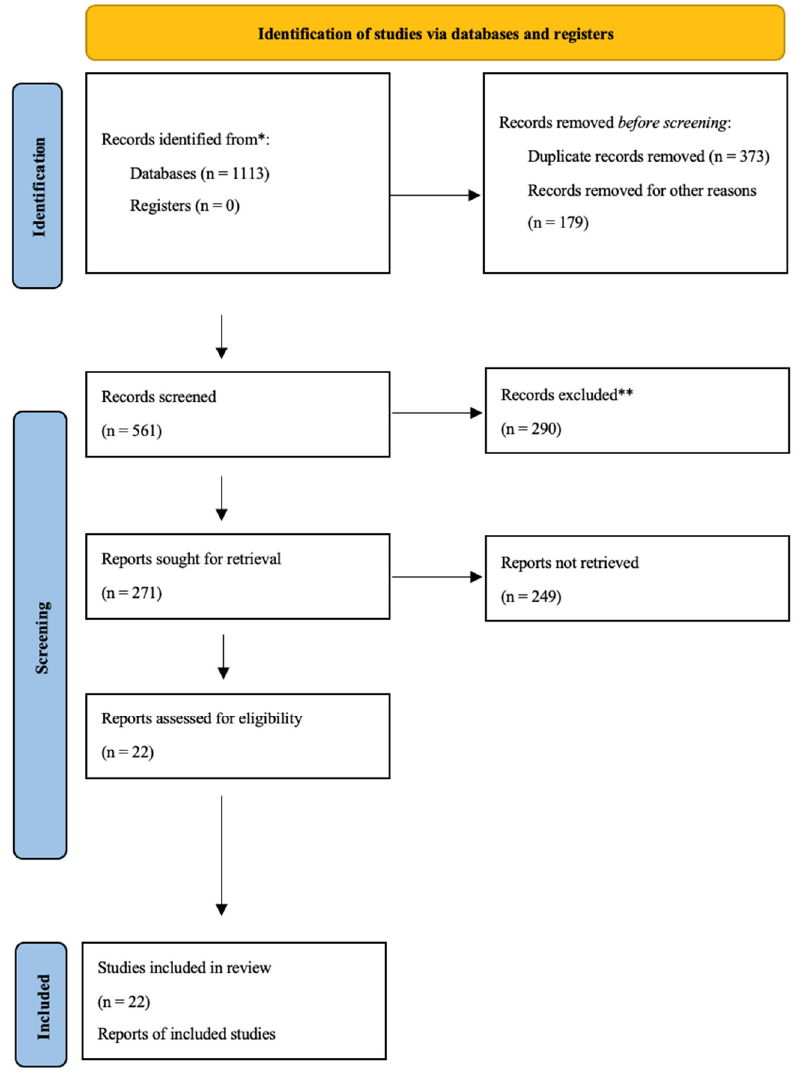
Figure 2. PRISMA guidelines used in a review of the literature. * The number of records identified from each database or registry searched is reported. ** No automation tools were used to obtain this figure; the records shown were excluded by a human operator.